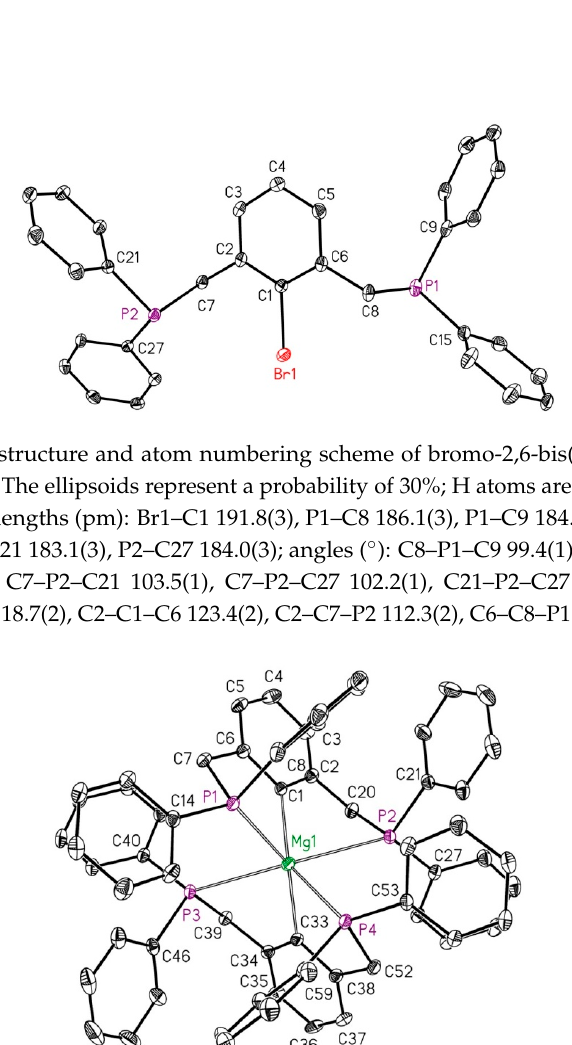
3 of 12 Figure 1. 31 P{ 1 H} NMR spectrum of the Grignard reaction of bromo-2,6-bis(diphenylphosphanyl- methyl)benzene ( 1a , RBr) with magnesium in tetrahydrofuran (see text, R = C 6 H 3 -2,6-(CH 2 PPh 2 ) 2 ; 162 MHz, 25 °C; [D 6 ]benzene was added to the reaction solution for the NMR measurement). The molecular structures and atom numbering schemes of 1a and 2 are depicted in Figures 2 and 3, respectively. In bromo-2,6-bis(diphenylphosphanylmethyl)benzene ( 1a ) the phosphanyl side arms are turned outside and hydrogen atoms of the methylene moieties (at C7 and C8) point toward the bromine atom. The P–C bond lengths to the sp 3 hybridized methylene groups C7 and C8 are slightly larger than the P–C values to the phenyl groups with sp 2 hybridized ipso-carbon atoms. The phosphorus atoms are in pyramidal environments with angle sums of 300.4° and 304.4° for P1 and P2, respectively. The C2–C1–C6 bond angle of the ipso-carbon atom (123.4(2)°) is slightly larger than 120° due to the positive charge on C1. The umpolung at this carbon via substitution of bromine by magnesium leads to narrower angles at the ipso-carbon atoms in complex 2 (C2–C1–C6 115.8(2)° and C34–C33–C38 115.6(2)°) due to electrostatic repulsion between the negatively charged electron pair and the neighboring bonds to the ortho-carbon atoms. The Mg1–C bond lengths of 219.3(3) and 218.3(3) pm lie in the expected range as also observed for other organomagnesium complexes [20–24]. The magnesium atom is rather small for the bite of the anionic ligand. Therefore, each phosphanyl-substituted aryl group additionally forms a strong Mg–P bond (Mg1–P1 269.2(1), Mg1–P4 268.9(1) pm) and a significantly longer bond (Mg1–P2 296.1(1), Mg1–P3 286.3(1) pm). The formation of coordinative Mg–P bonds increases the angle sums at the phosphorus atoms, taking